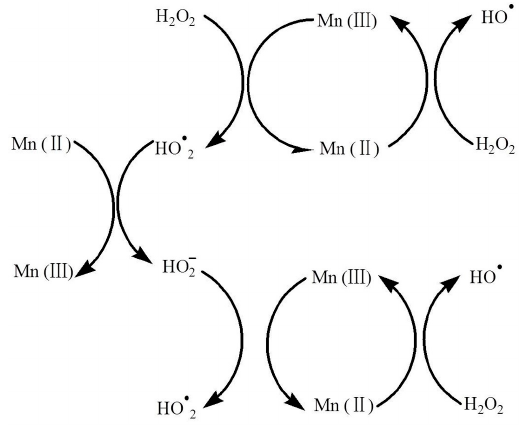
Figure 13. Degradation mechanism of MB in MnO nanomixtures .